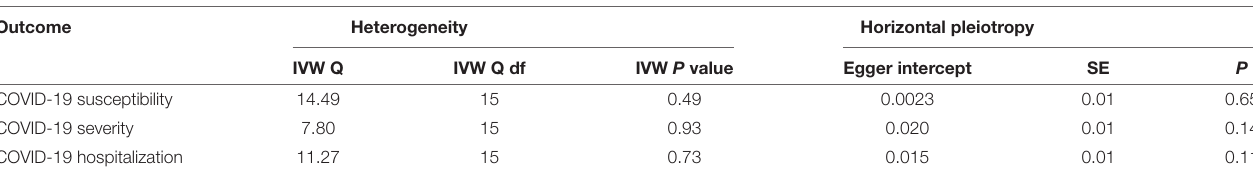
TABLE 1 | Heterogeneity and horizontal pleiotropy analyses